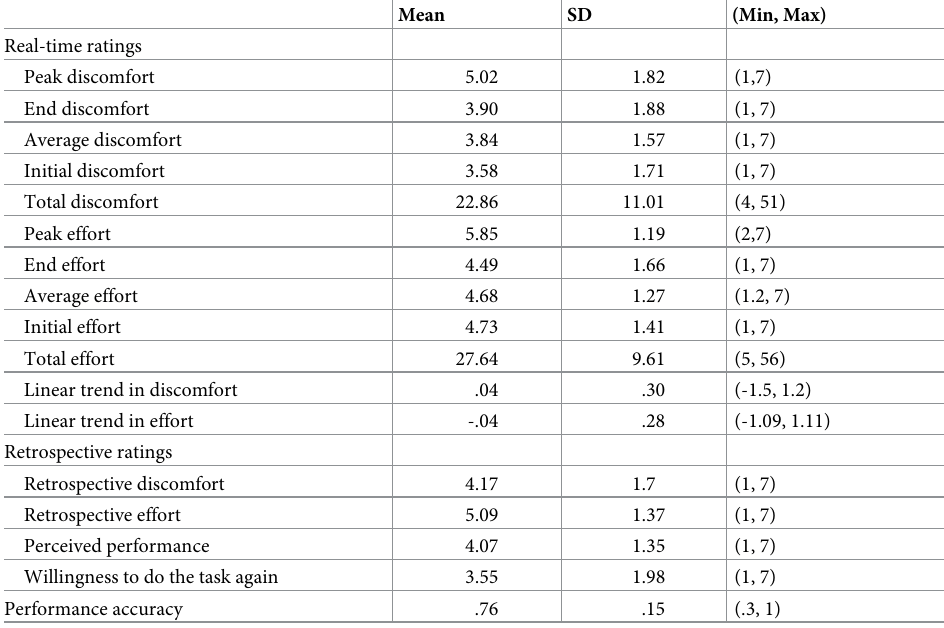
Table 1. Mean (SD) ratings, trends and performance on the PASAT.